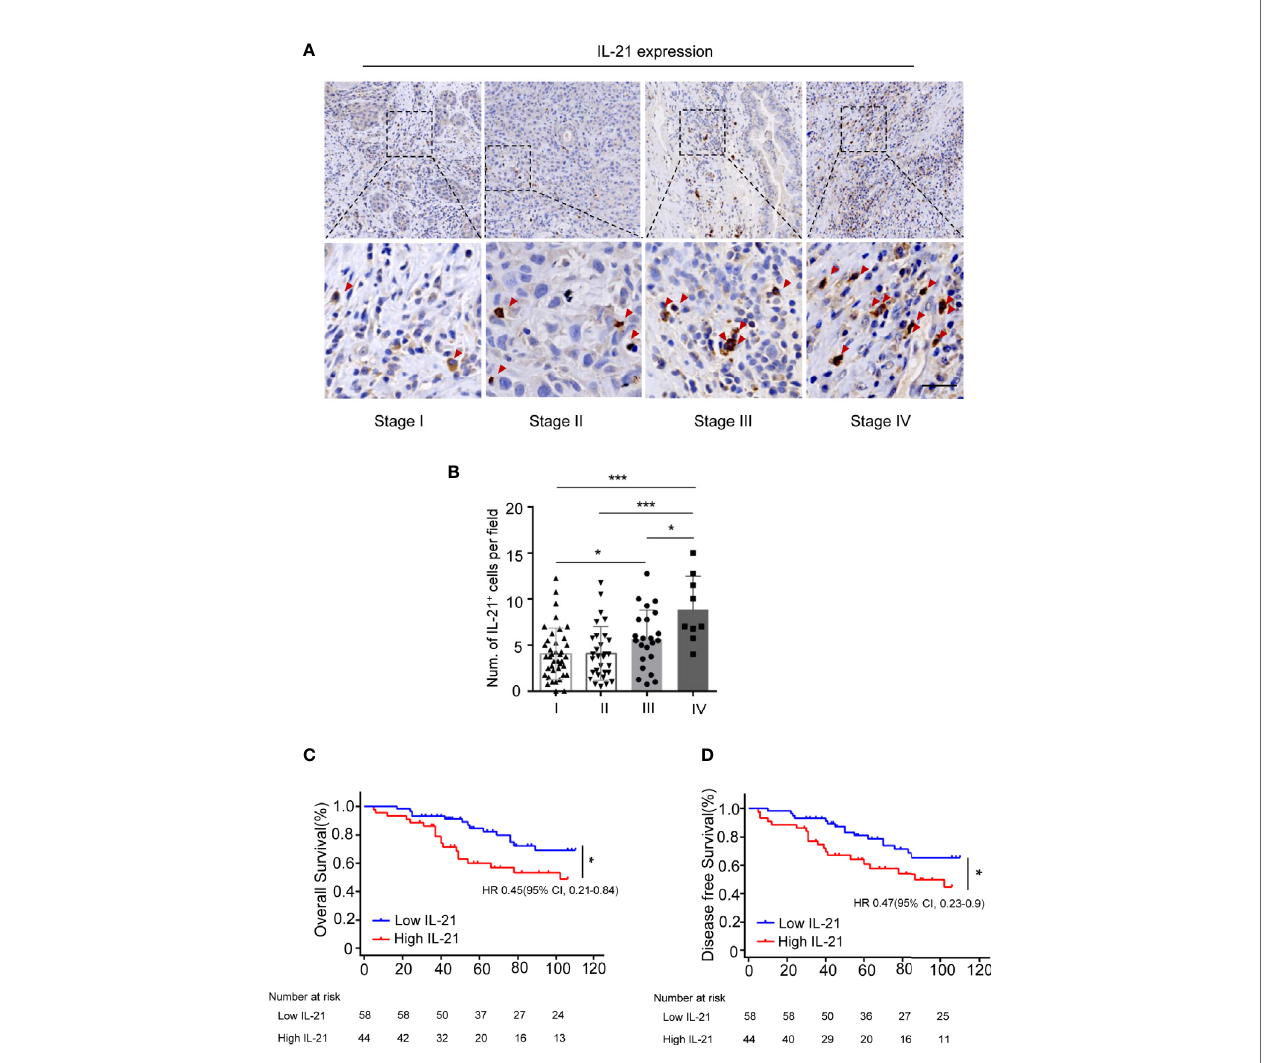
FIGURE 2 | Accumulation of IL-21 + cells are associated with poor prognosis of patients with HNSCC. (A) Representative images showing staining of IL-21 + cells within the tumor stroma. Positive cells are stained brown. (Red arrowheads, Scale bar, 50 m m). Bottom panels (400×)are magni fi ed images of the boxed area in the corresponding upper panel (100×). (B) IL-21 + cell in fi ltration in patients with each of the stage I, II, III and IV (n=102, *P < 0.05, ***P < 0.001, by One way ANOVA.). (C, D) Kaplan-Meier survival curve of HNSCC patients with low and high numbers of tumor in fi ltrating IL-21 + cells, compared by the log-rank test. Patients with high IL-21 + cells levels had signi fi cantly poorer overall survival (C) and disease-free survival (D) compared with individuals with